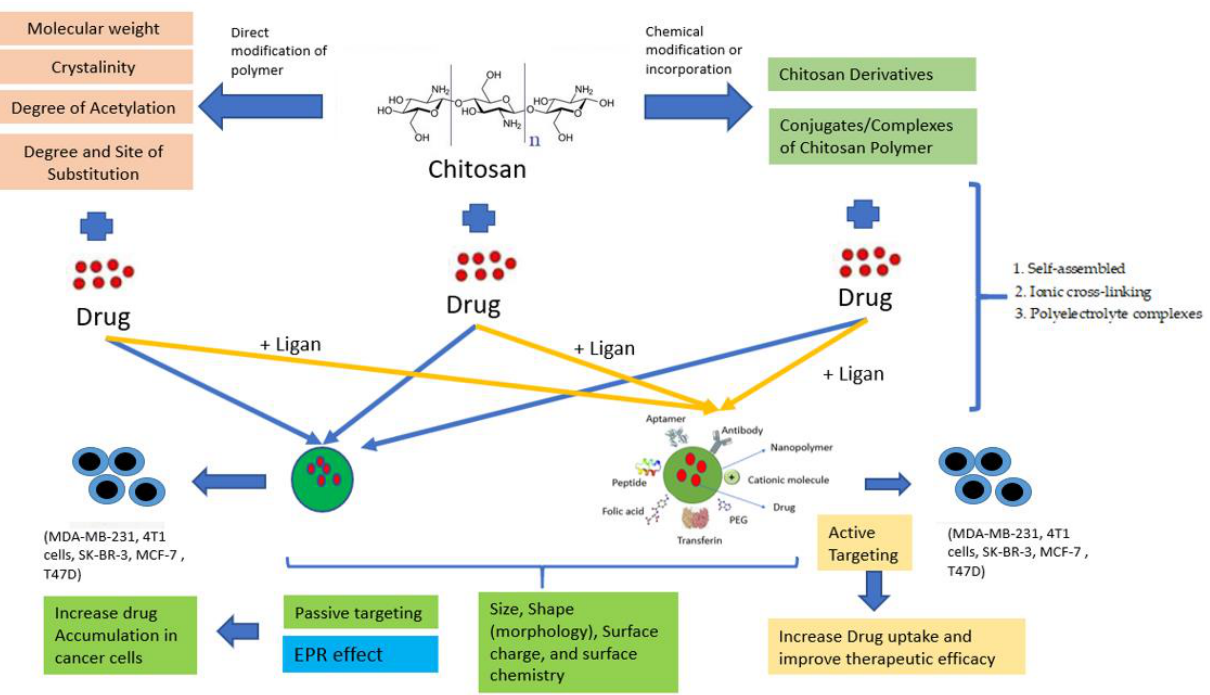
Figure 6. Passive and Active Targeting in ChNPs.